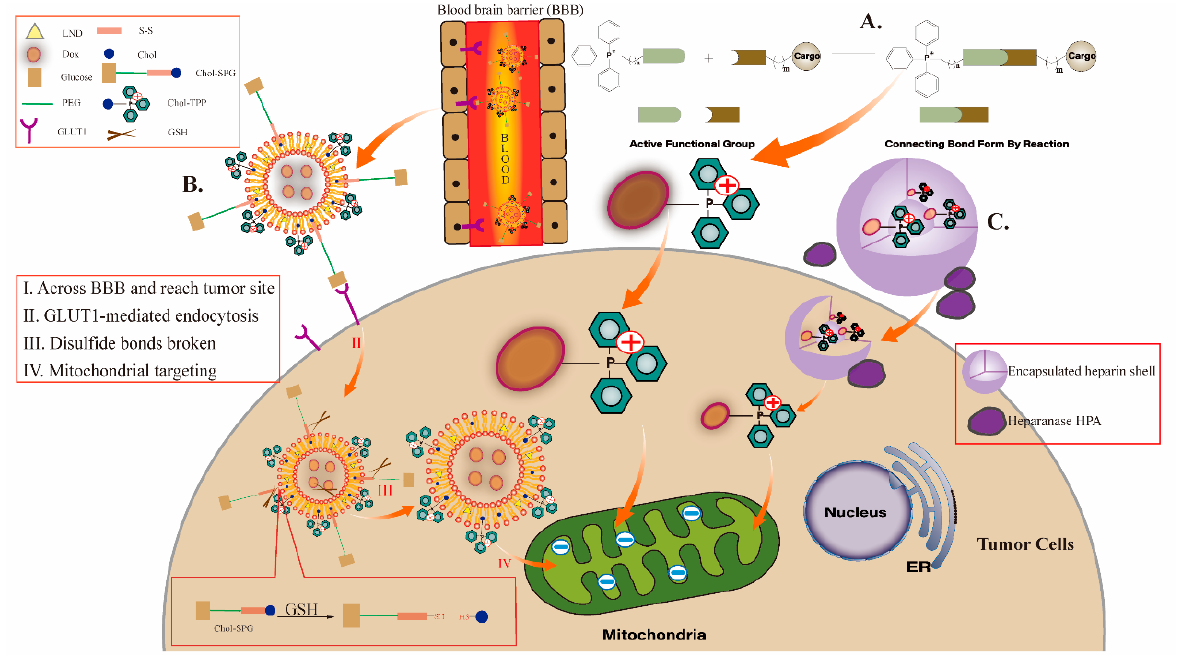
Figure 4. A. TPP directly conjugated with drug molecules. This is a typical molecular structure consisting of a functional part, a junction sequence and a targeting part. TPP binds to the functional part (Cargo) through a functional group reaction. B. TPP as ligand modification. For example, Lip-SPG, a multi-targeted redox liposome co-modified with glucose and TPP, can cross the BBB via GLUT1 and target tumor cell mitochondria for effective delivery of DOX and LND for glioma therapy. Chol: Cholesterol; GSH: Glutathione; LND: Lonidamine; PEG: Polyethylene glycol. C. TPP nanosystems encapsulated in special shells. For example, a heparin shell is wrapped around the surface of the drug molecule and heparanase, a tumor microenvironment promoter, is specifically expressed in most tumor cells. When located near tumor cells, the heparin shell is disassembled and the drug molecule is released to target mitochondria for action, thus avoiding the formation of non-specific aggregation of TPP with negatively charged components of the